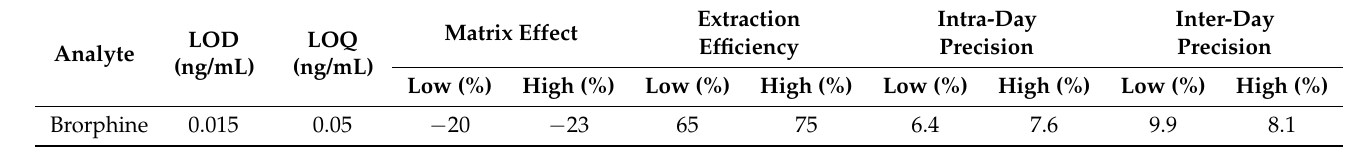
Table 2. Validation parameters of the method for the identification and quantitation of brorphine in